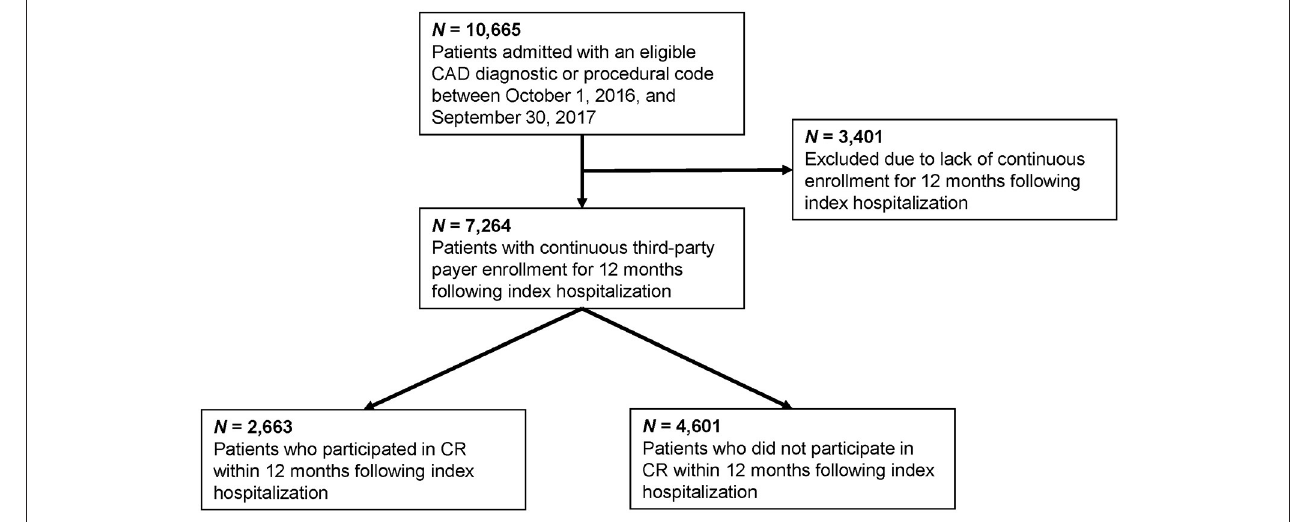
FIGURE 2 | Patient flowchart.